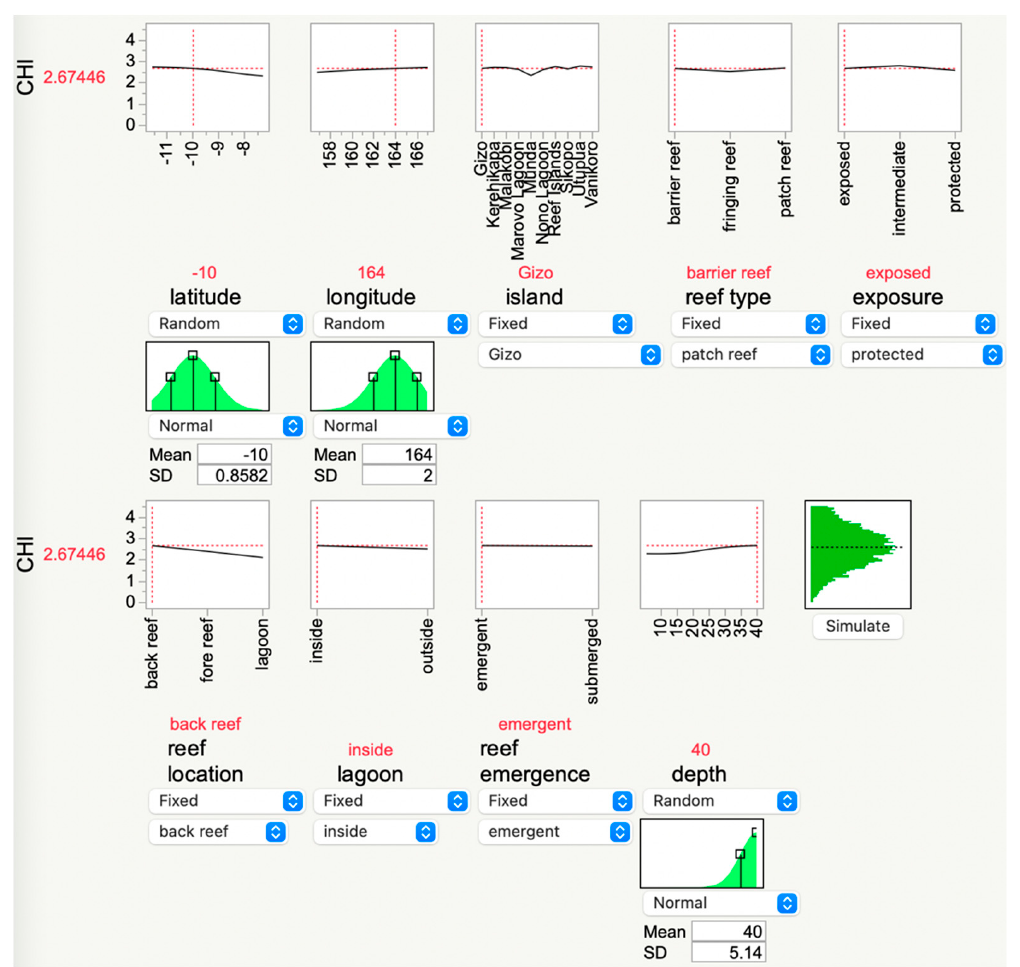
Figure 6. JMP ® Pro’s “simulator,” which allows users to input data from their study reefs and then calculate a theoretical coral health index (CHI) score. In this example, the depth was increased to 40 m, causing the predicted CHI value to increase from the local mean of 2.5 to 2.67. A manager in the Solomon Islands can modify the input parameters of reef areas of interest, and the AI will update the theoretical CHI accordingly. This GUI is hosted at https://coralreefdiagnostics.com/environmental-consultation-and-evaluation.